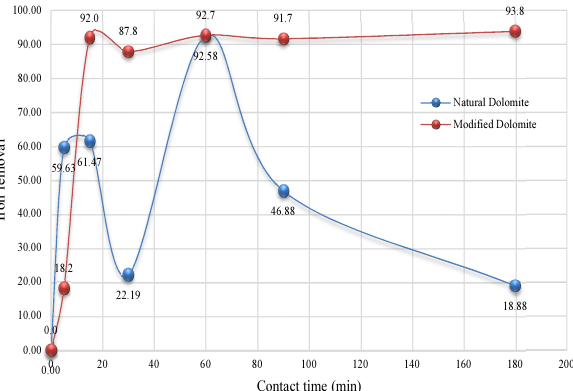
Fig. 5. Comparison of removal efficiency (%) of iron from solution (5 mg/l) by natural dolomite and modified dolomite (1 g) within specified contact times